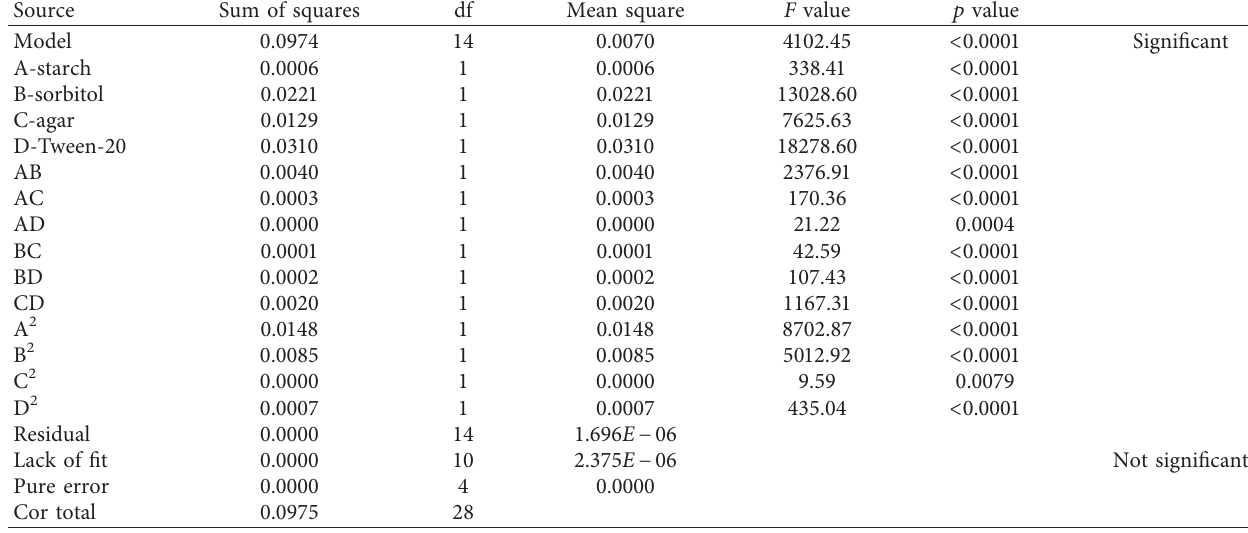
Table 3: ANOVA analysis for predicted second-order polynomial